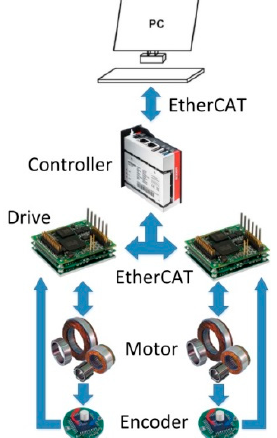
Figure 17. The hardware configuration.